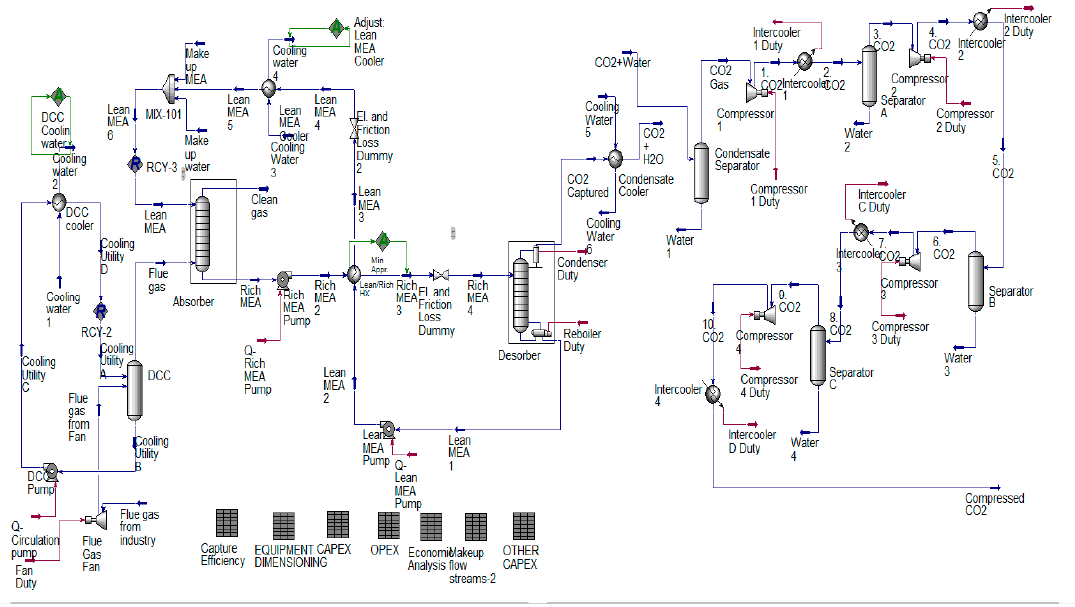
Figure A1. The Aspen HYSYS simulation process flow diagram.